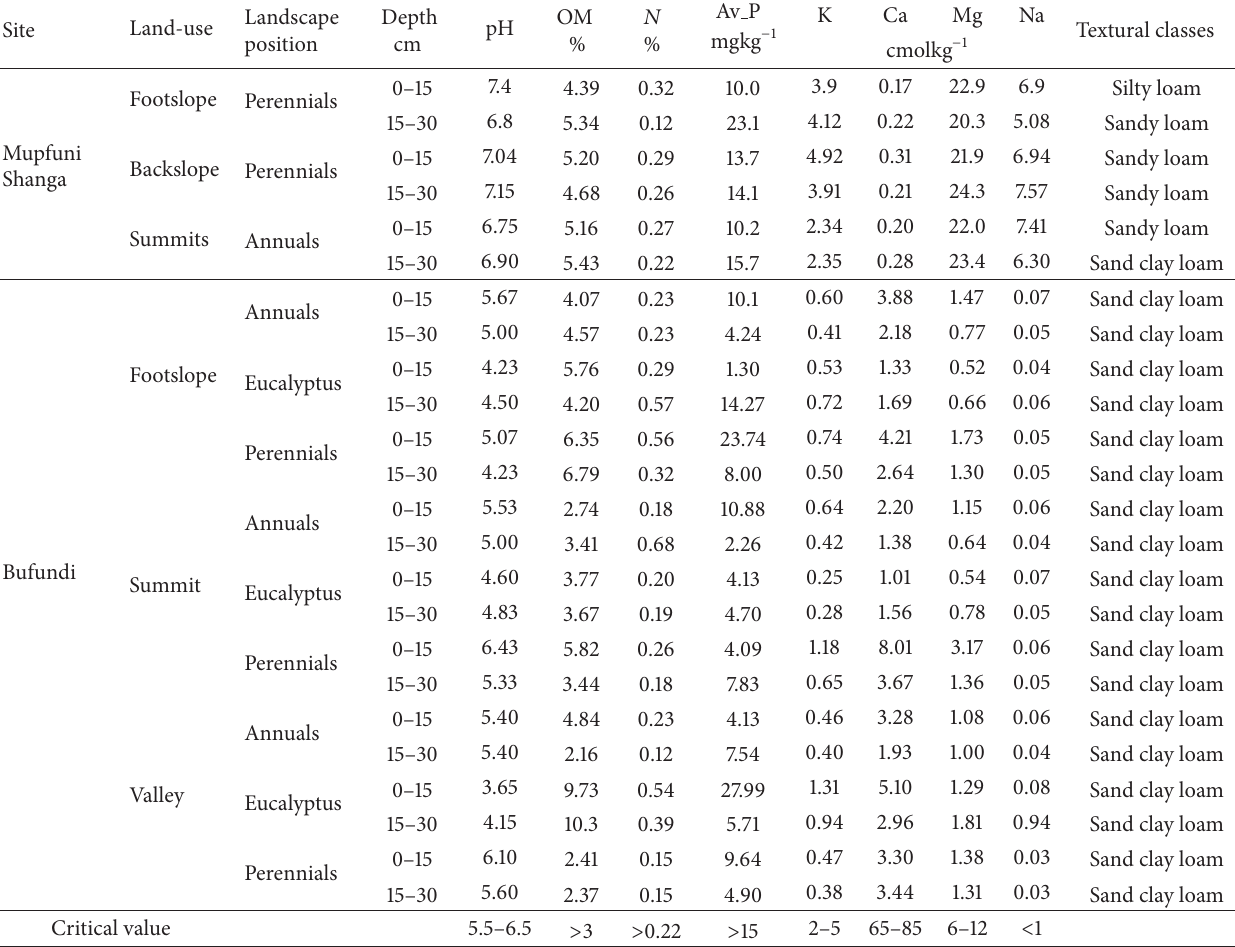
Table 2: Soil properties under the different land-use/cover in two selected microcatchments. Site